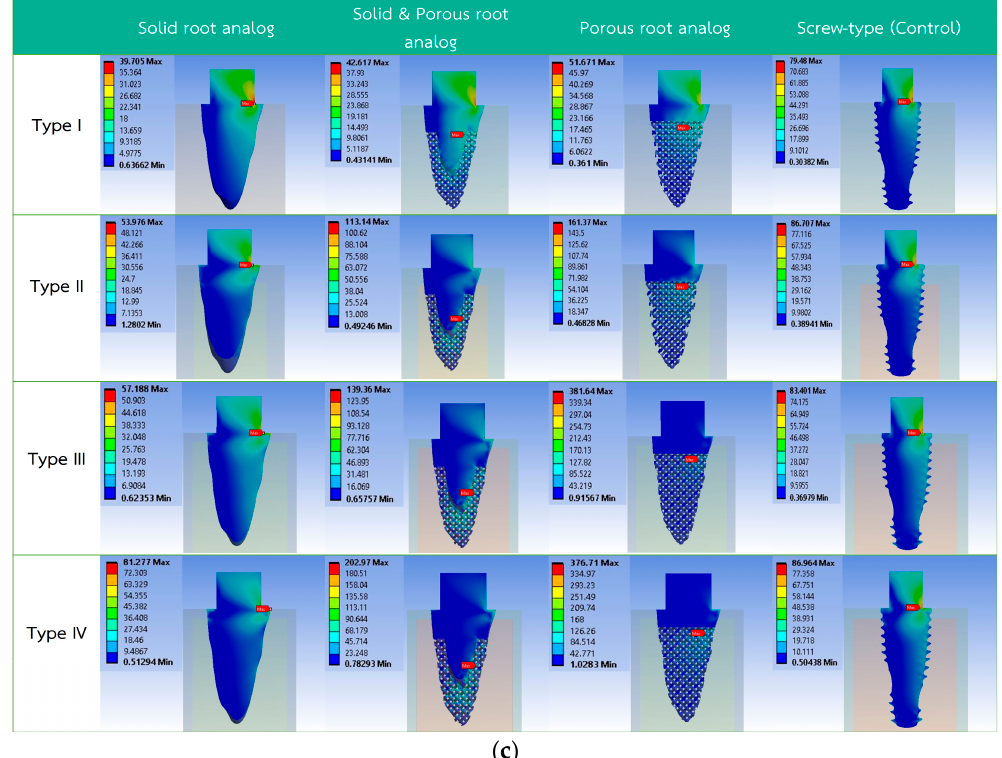
Figure 2. Von Mises stress distribution of all finite element models: ( a ) von Mises stress in cortical bone; ( b ) von Mises stress in cancellous bone; ( c ) von Mises stress in implant.